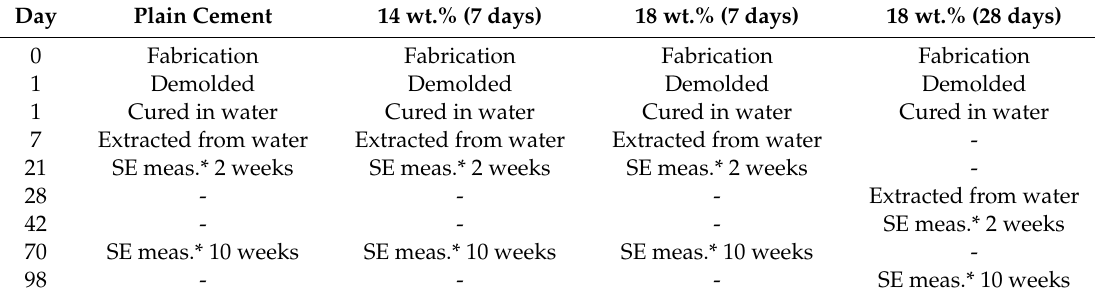
Table 1. Fabrication and measurements of the cement composites.